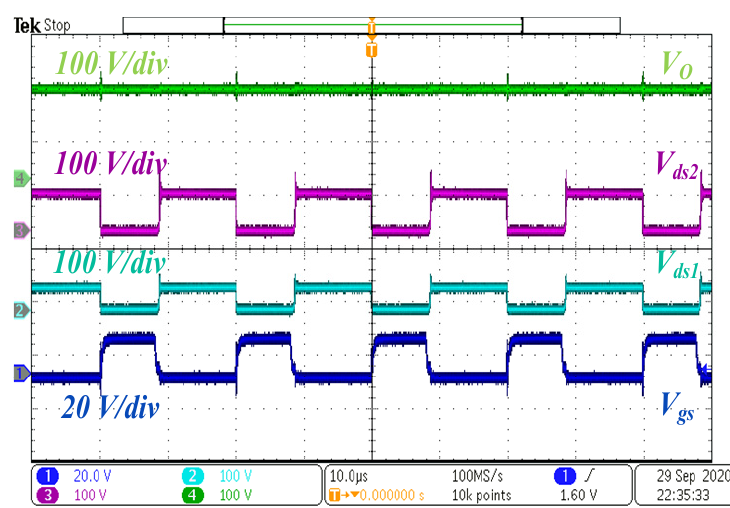
Figure 16. Capacitor voltages of C 1 , C 2 , and C 4 at D = 0.4.